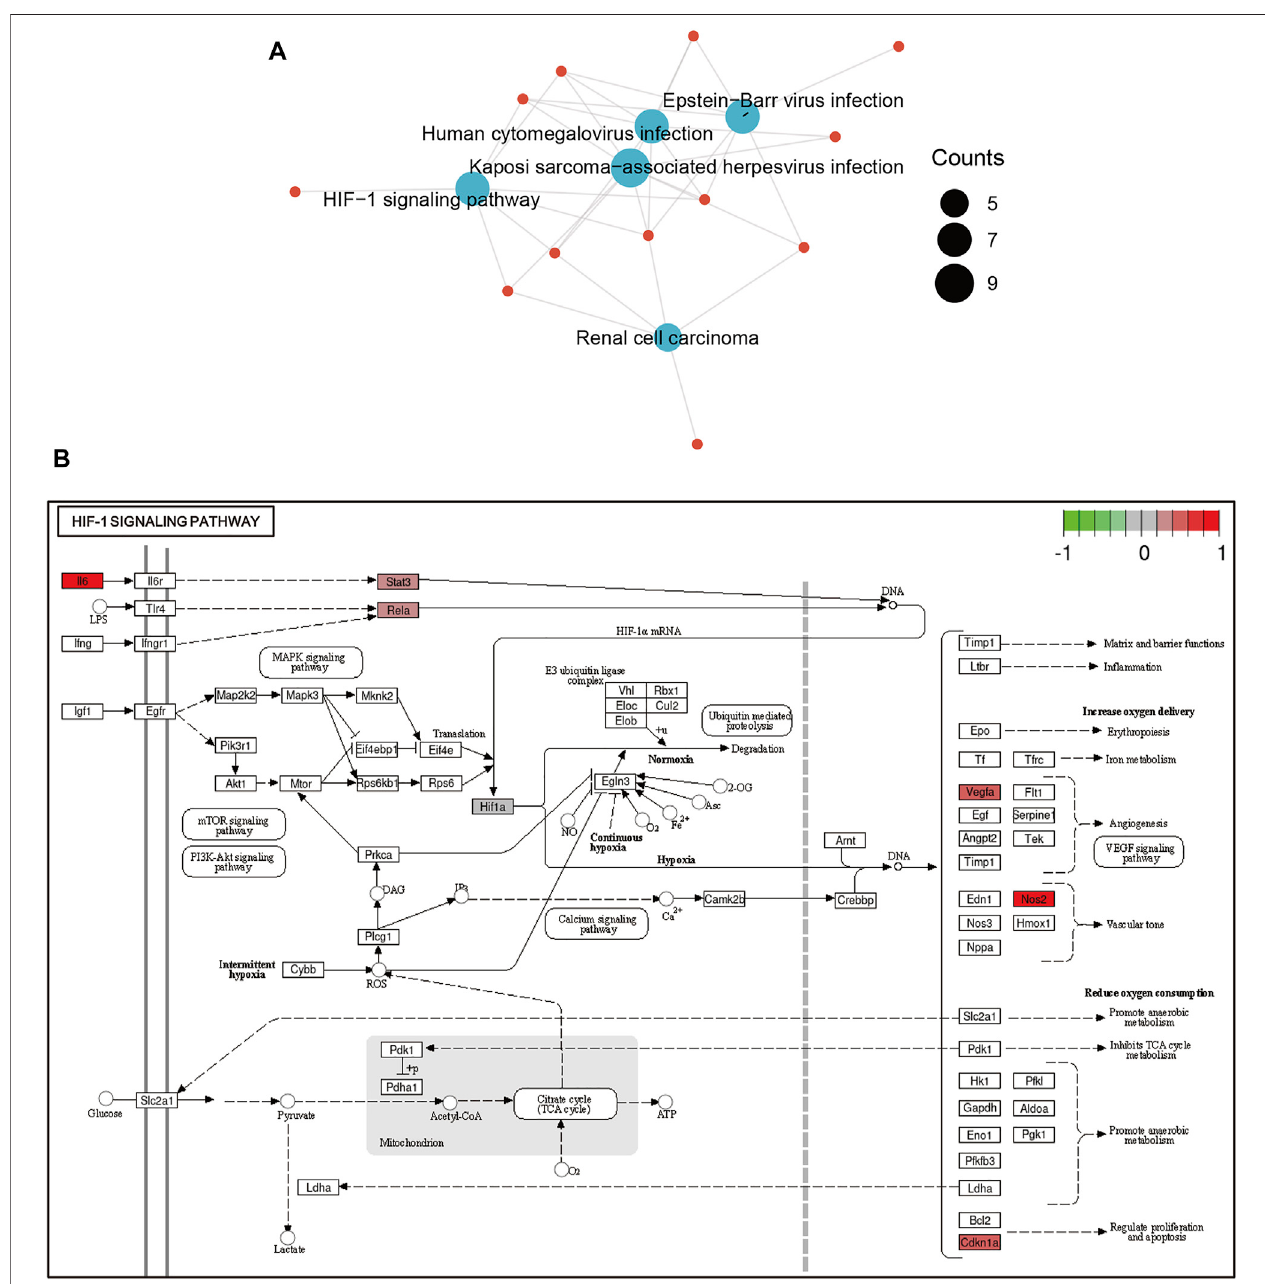
FIGURE 6 | Functional analyses of ferroptosis DEGs in Cluster 1. (A) The HIF-1 signaling pathway was signi fi cantly enriched in Cluster 1. (B) Ferroptosis DEGs enriched in the HIF-1 signaling pathway were plotted using PATHVIEW. Abbreviations: DEGs, differentially expressed genes.